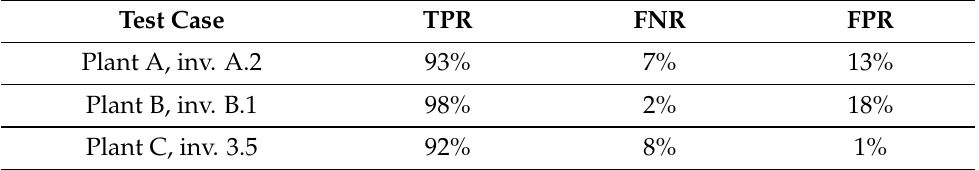
Table 8. Summary of the performance results on the three case